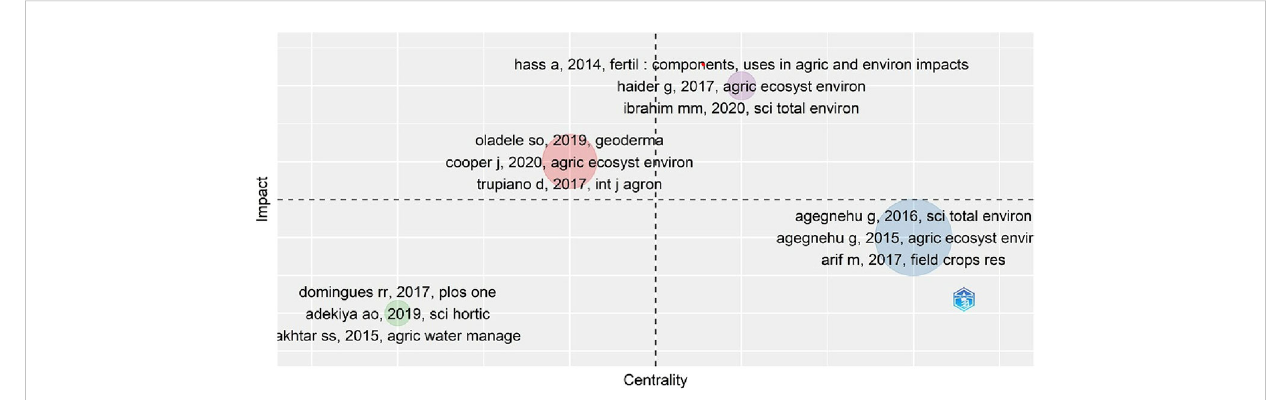
FIGURE 6 Clusters by documents